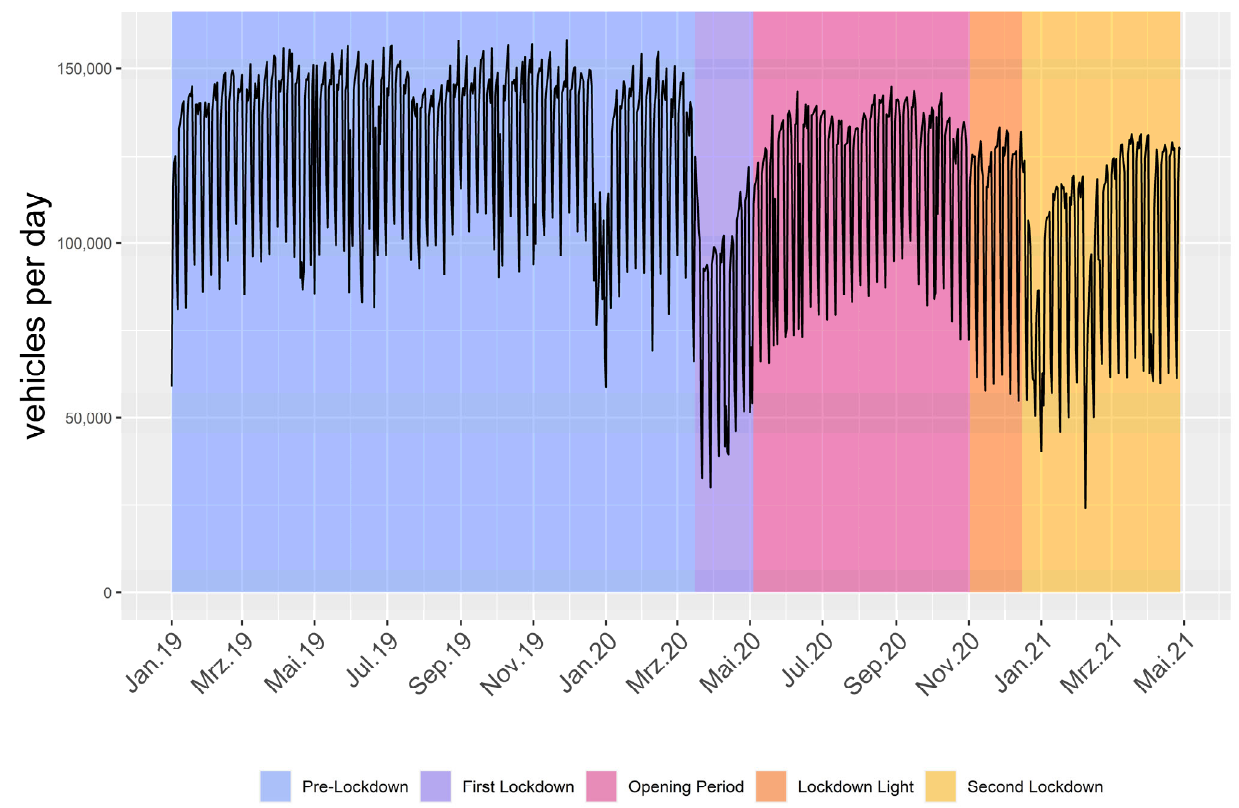
Figure 2. Traffic volume per day over the study period on the A40 between the German cities of Bochum and Essen.